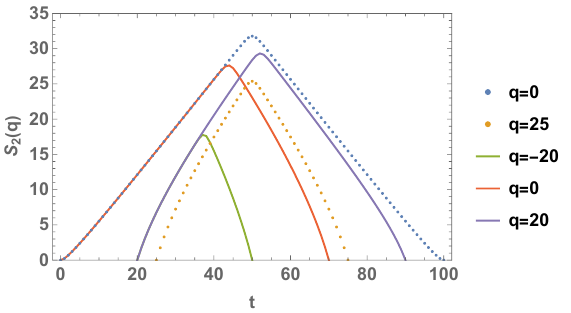
Figure 1 . Symmetry-resolved second Rényi entropy (3.7) for different values of q with Q = 0 (denoted by dotted lines) and Q = 30 (denoted by solid lines). N = 100 is